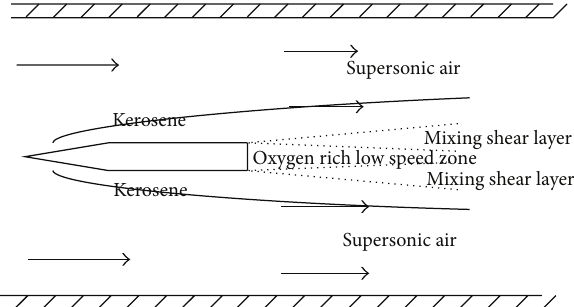
Figure 6: Flow structure at the rear part of the strut-jet.